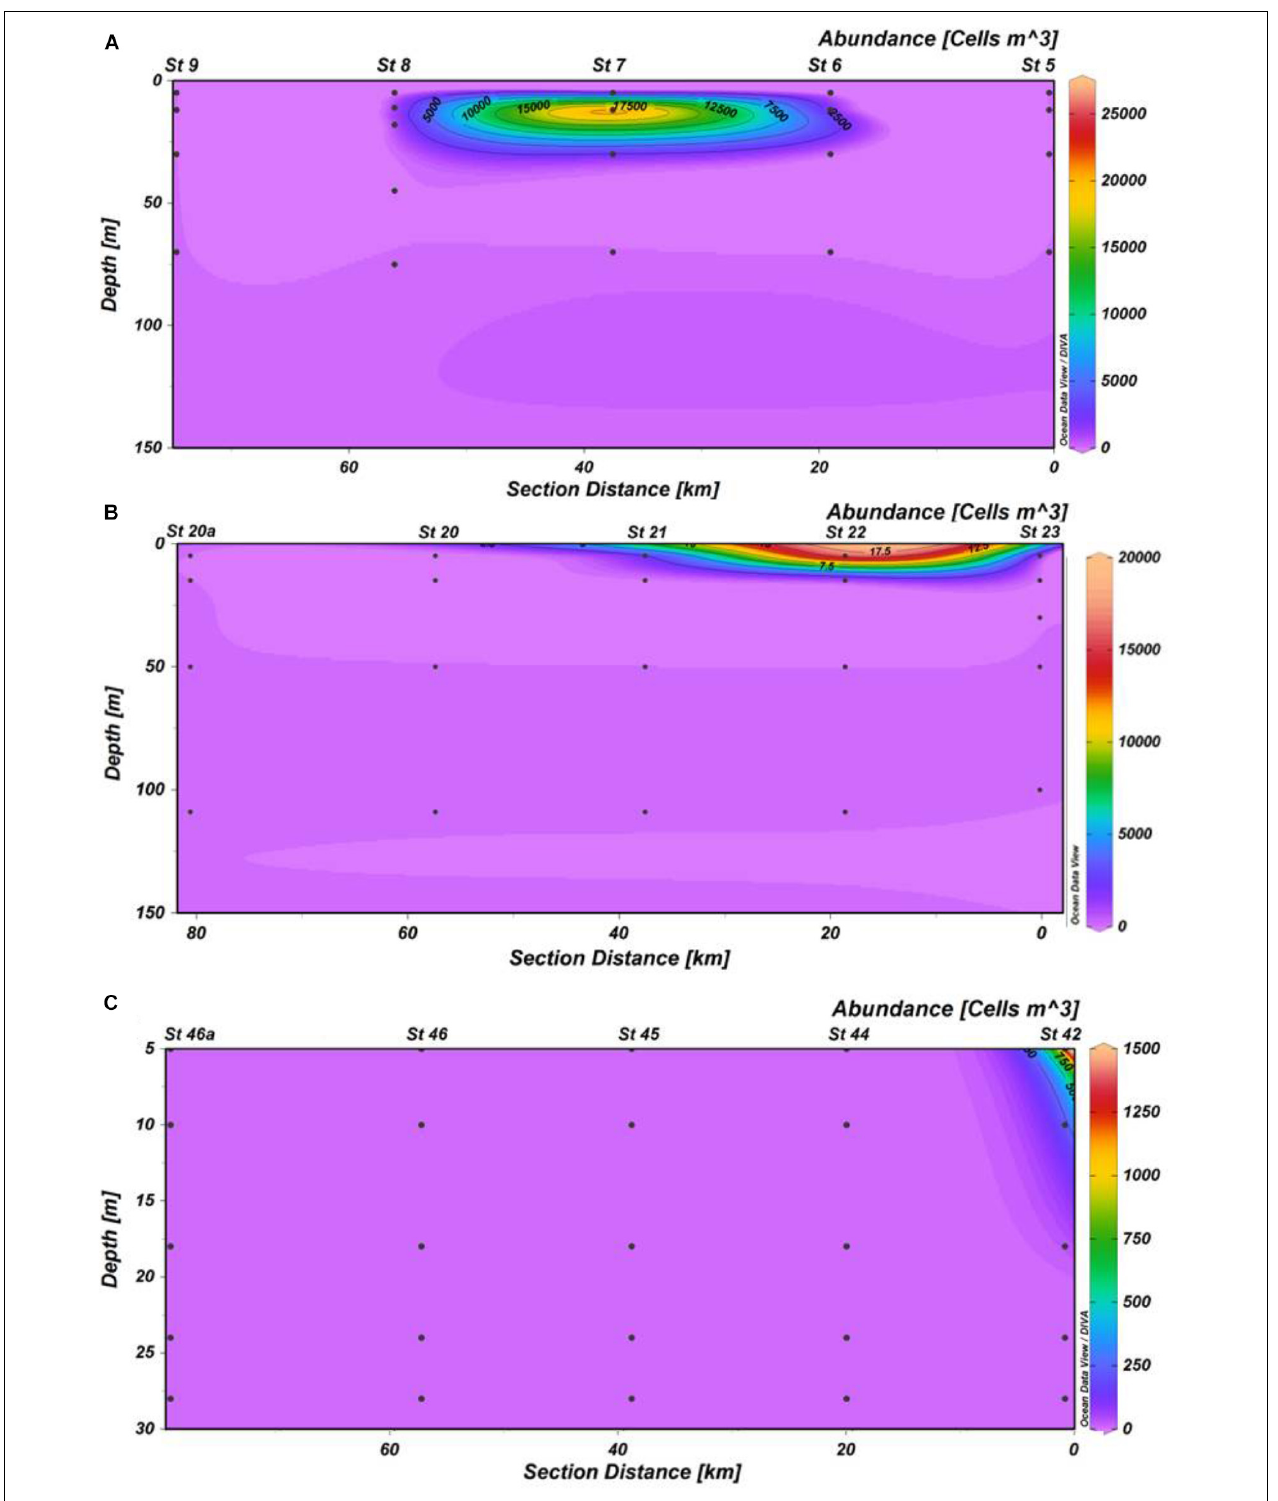
FIGURE 6 | Vertical distribution of Alexandrium tamiyavanichii cell densities (cells m − 3 ) in three transects. (A) Cabo Corrientes; (B) Manzanillo; (C) Acapulco.